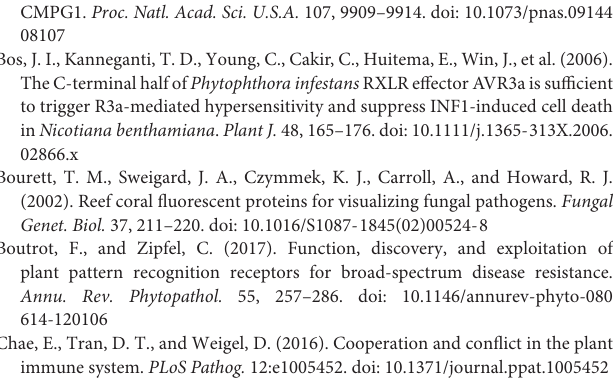
FIGURE S1 | Amino acid sequences derived from the open reading frame of SCRE2 . SCRE2 encodes a protein with 130 amino acid residues. Underlined is the predicted SP of SCRE2. The 68–85 amino acid residues as a functional